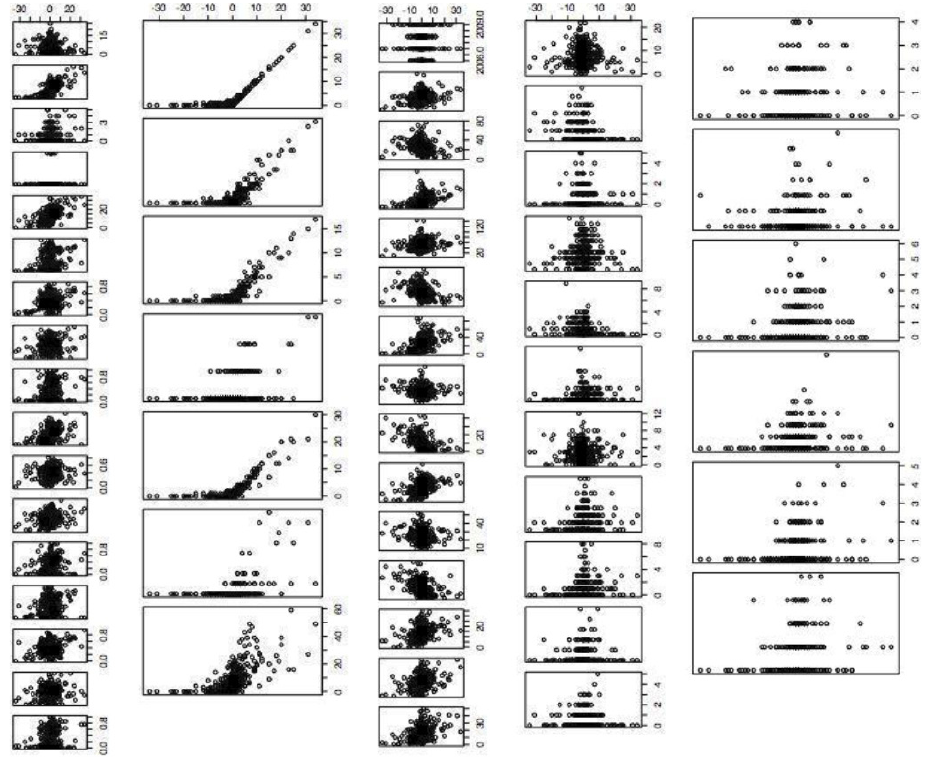
Figure 2: Relation between (cid:100) GSD and each input variables as defined in Table 1 ( (cid:100) GSD is illustrated in x axe and input variables in y axe